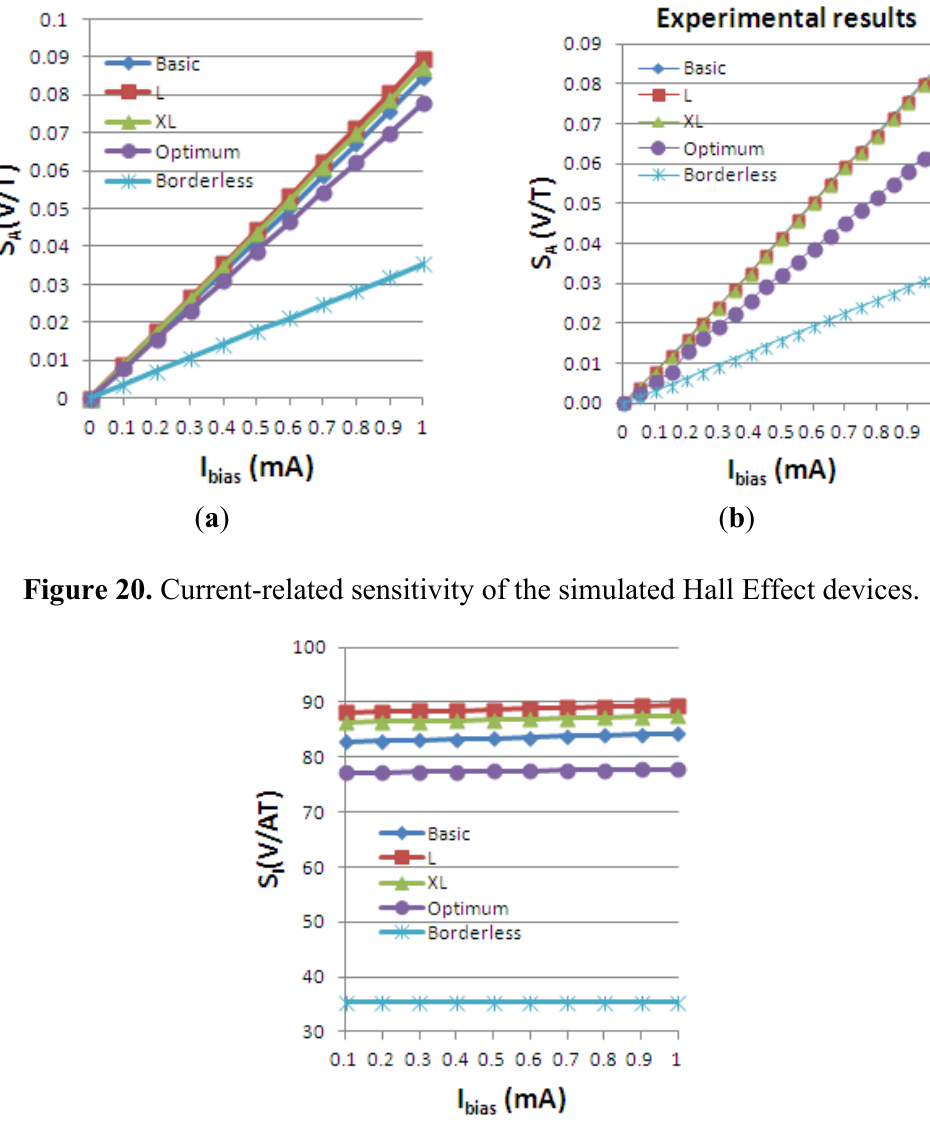
Figure 19. Hall Effect devices absolute sensitivity vs. I measured ( b ).